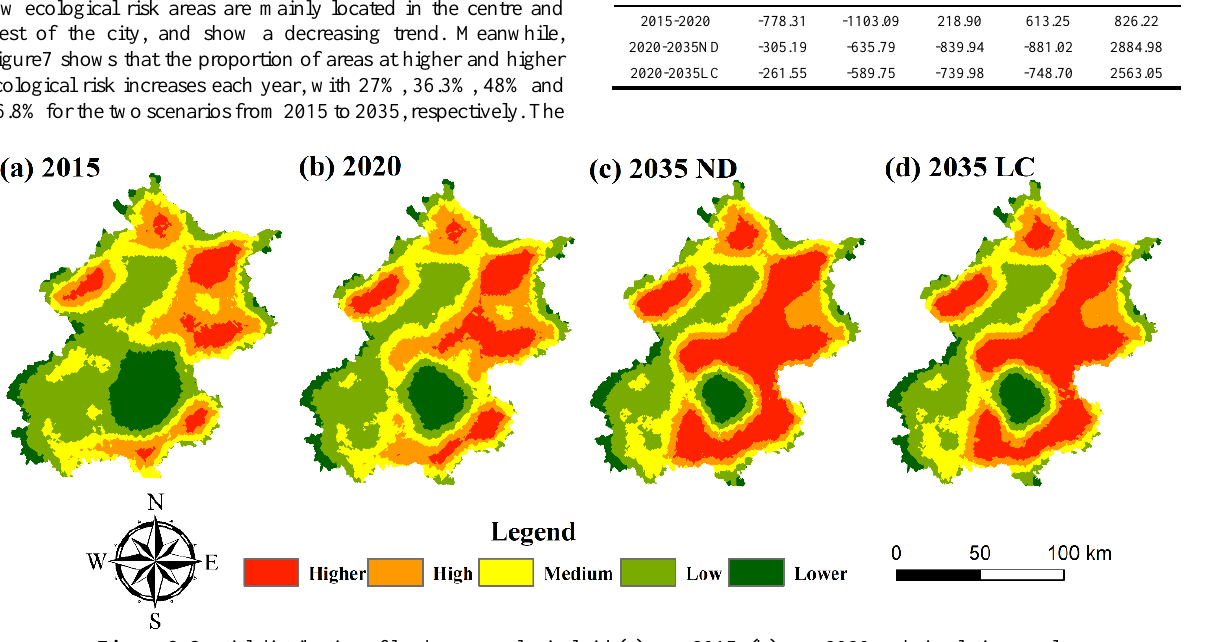
Figure 6. Spatial distribution of landscape ecological risk(a) year 2015; (b) year 2020 and simulation